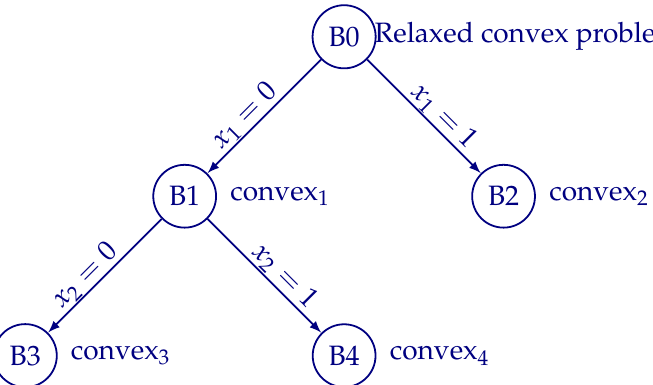
Figure 3. Example of the branch and bound algorithm for the proposed